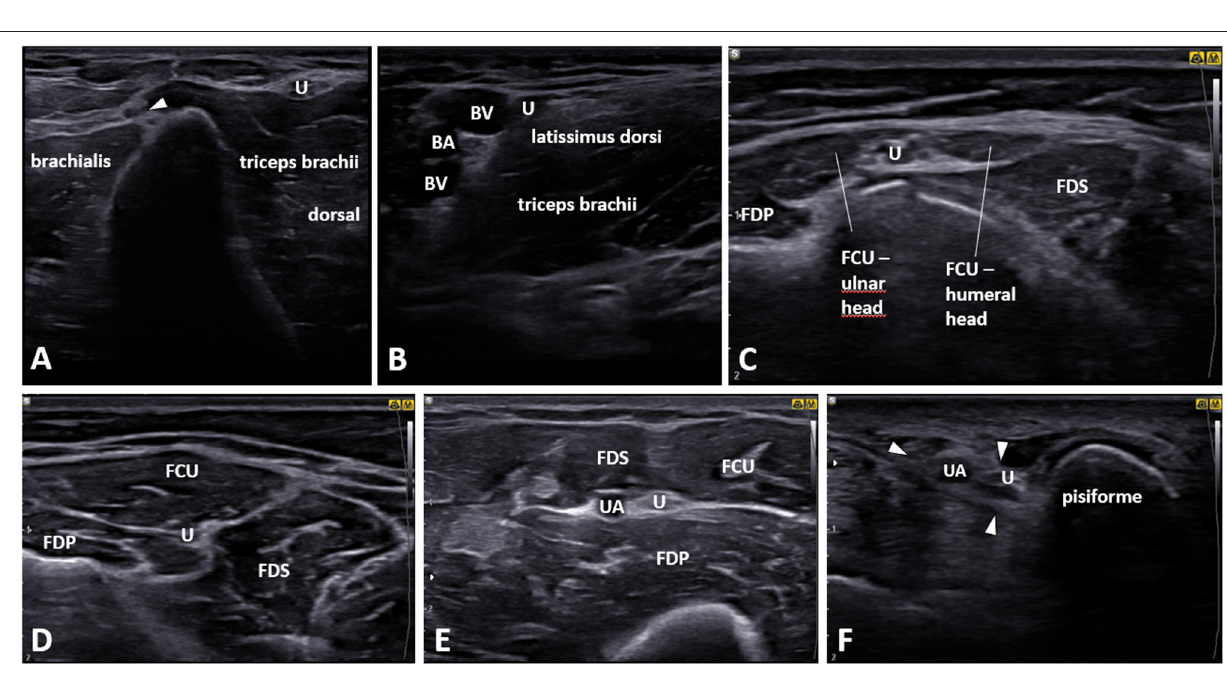
FIGURE 7 | Proximal and distal tracking of the ulnar nerve starting from the retroepicondylar groove. (A) Midarm, arrowhead: medial intermuscular septum. (B) Proximal midarm. (C) Flexor carpi ulnaris muscle (FCU) level. (D) Proximal forearm. (E) Proximal mid-forearm, the ulnar nerve accompanied by the ulnar artery. (F) Ulnar nerve in Guyon canal ( arrowheads ). FDP, flexor digitorum profundus muscle; FDS, flexor digitorum superficialis muscle; U, ulnar nerve; BA, brachial artery; BV, brachial vein. kinesiotaping, exercise and neurodynamic